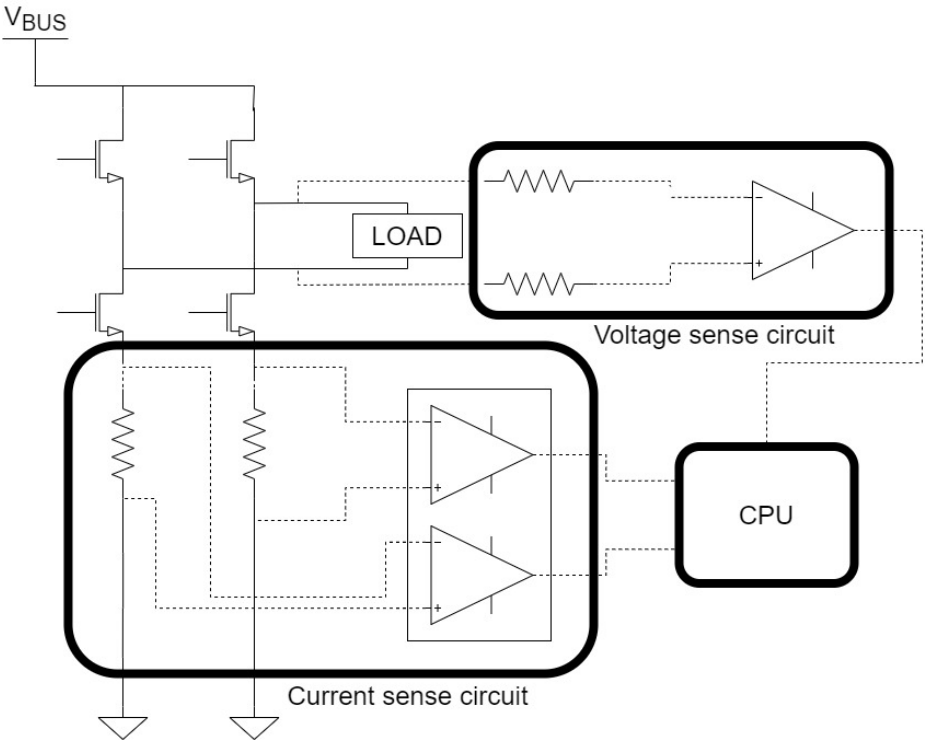
Figure 2. Current and voltage sensing